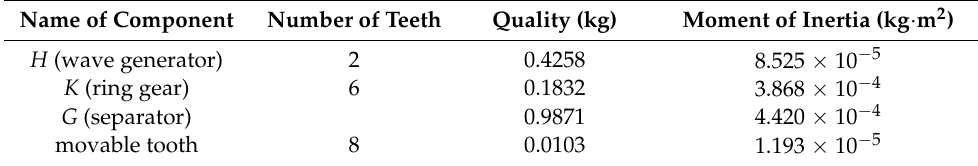
Table 1. Basic parameters of the transmission system.